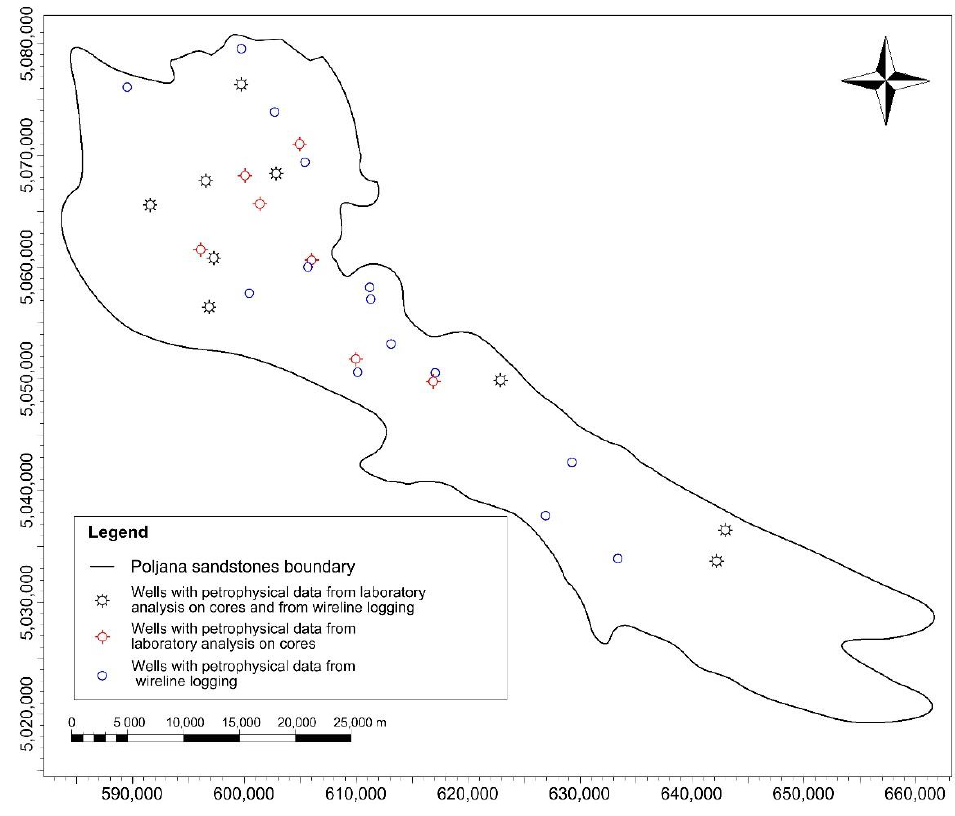
Figure 2. Areal distribution of the DSA Poljana with wells used for porosity upscaling.